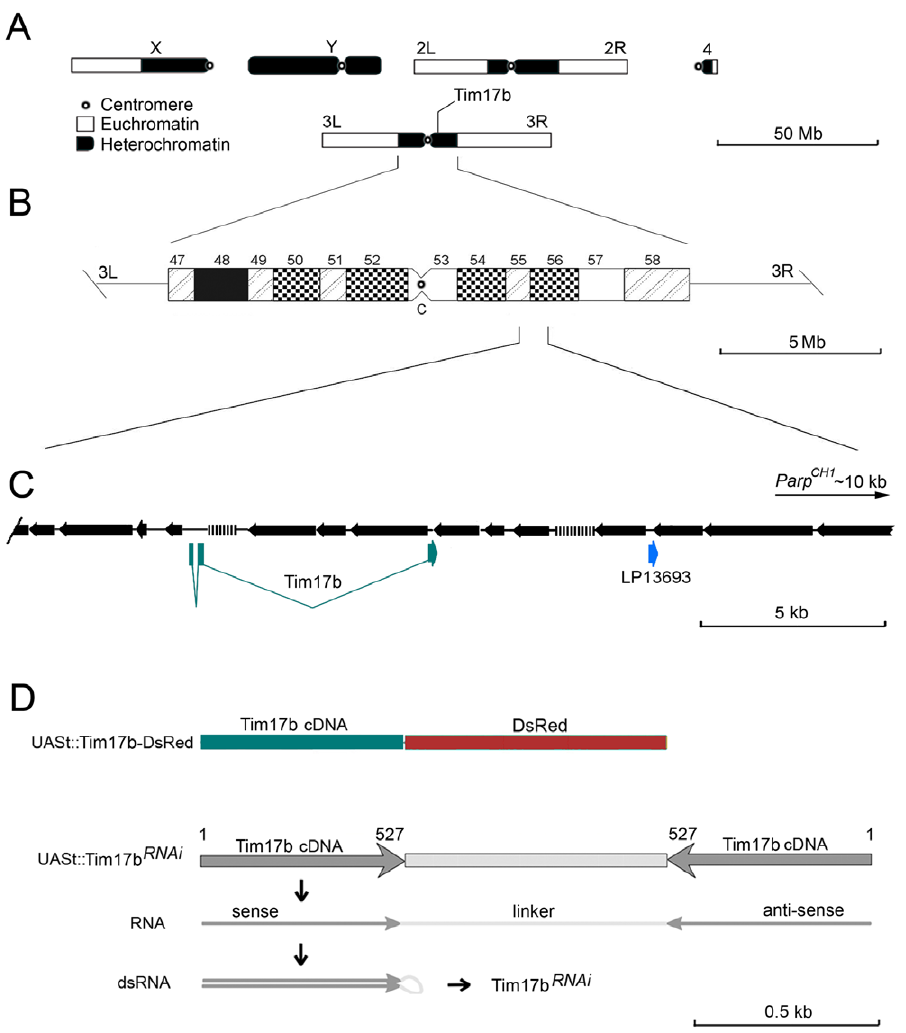
Figure 1. Tim17b gene is located within constitutive heterochromatin of third chromosome. A. Schematic illustration of Drosophila melanogaster chromosomes. Heterochromatic regions are shown in black. B. An ideogram of chromosome 3 heterochromatin. C. A scheme summarizing the sequence organization around Tim17b locus. Retrotransposable and transposable repeated DNA are shown by black arrows (arrowhead – 3 9 end). Genes identified by homology to known cDNAs are shown below (blue boxes correspond to exons). Distance to closest characterized locus ( Parp ) is indicated. D. Generation of UAS-Tim17b-DsRed and UAS-Tim17b RNAi transgenes. Structure of transgenic constructs is shown. Nucleotide positions of Tim17b cDNA are